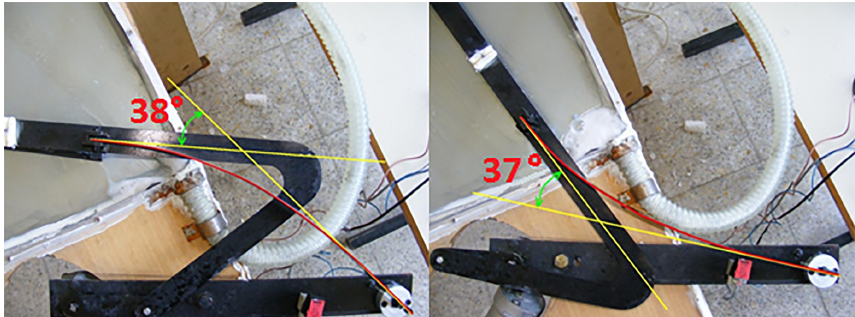
Figure 13. Deflections of the compliant link from the neutral